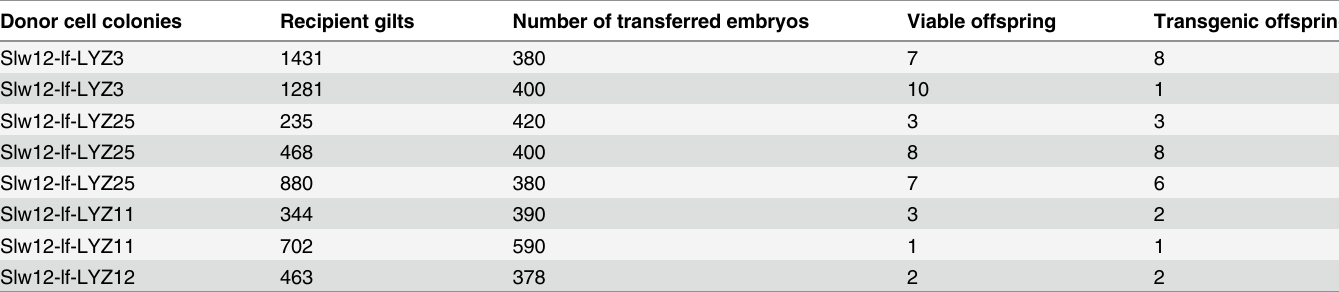
Table 1. Transplantation results of transgenic cloned embryos.